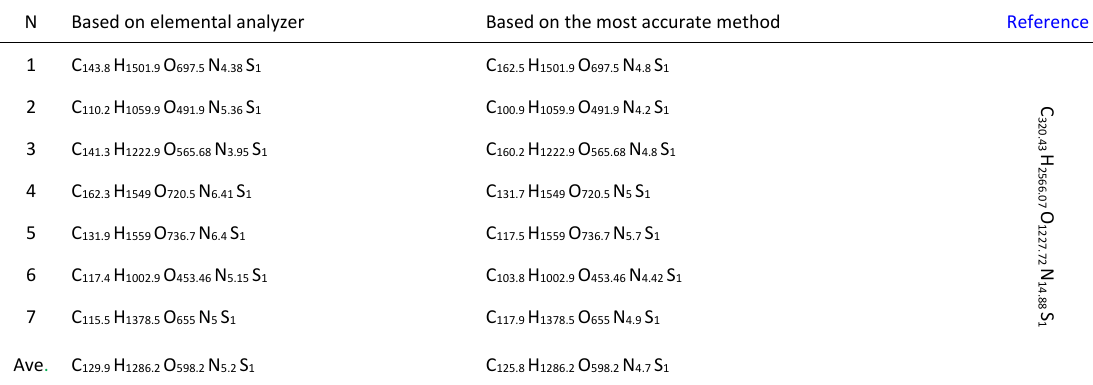
Table 8: Chemical equation (with water) for determination of food waste in different ways (Tchobanoglous et al., 1993) N Based on elemental analyzer Based on the most accurate method